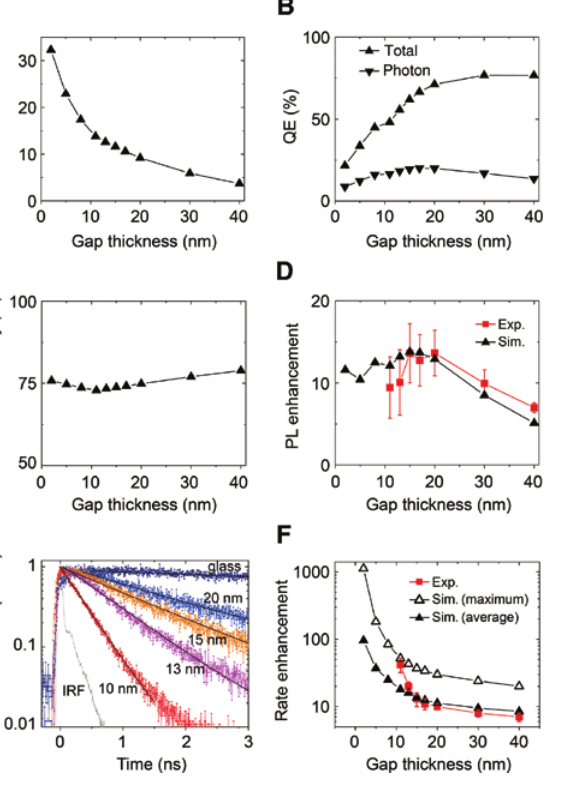
Figure 5: Gap thickness dependence of PL intensity and decay rate enhancement. (A) Simulated average excitation rate enhancement for emitters in the gap compared to those on glass as a control. (B) Simulated average total QE and photon QE. (C) Simulated average collection efficiency into the NA of 0.9. (D) Measured and simulated total PL enhancement relative to quantum dots on glass as a function of the gap thickness (measured as the PL peak intensity ratio without area normalization). The simulated enhancement for each gap thickness is obtained by averaging over the excitation laser spot with the diameter of 360 nm. The excitation power density is 20 W/cm 2 in all measurements. (E) Measured time-resolved emission decay curves for varied gap thicknesses, where the measured curves (in different colors) are fitted by a single-exponential function and represented by black lines. (F) Measured and simulated decay rate enhancement as a function of the gap thickness, where the simulated results include the maximum rate enhancement and the average counterpart over the excitation spot